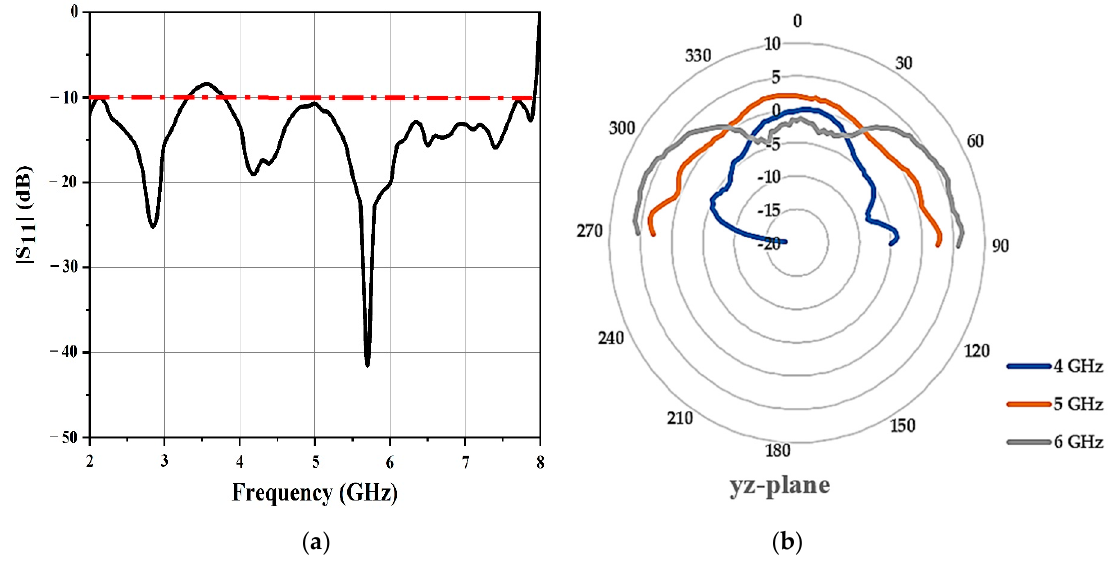
Figure 11. ( a ) Measured reflection coefficients of the antenna and ( b ) measured yz-plane (E-plane) radiation pattern at different frequencies.